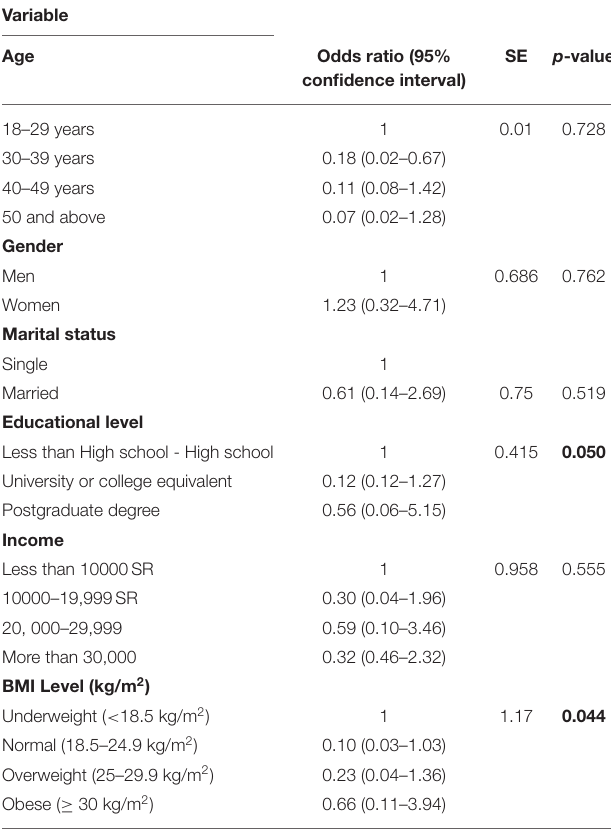
TABLE 4 | Logistic regression predicting Likelihood toward attitudes in menu calorie labeling.